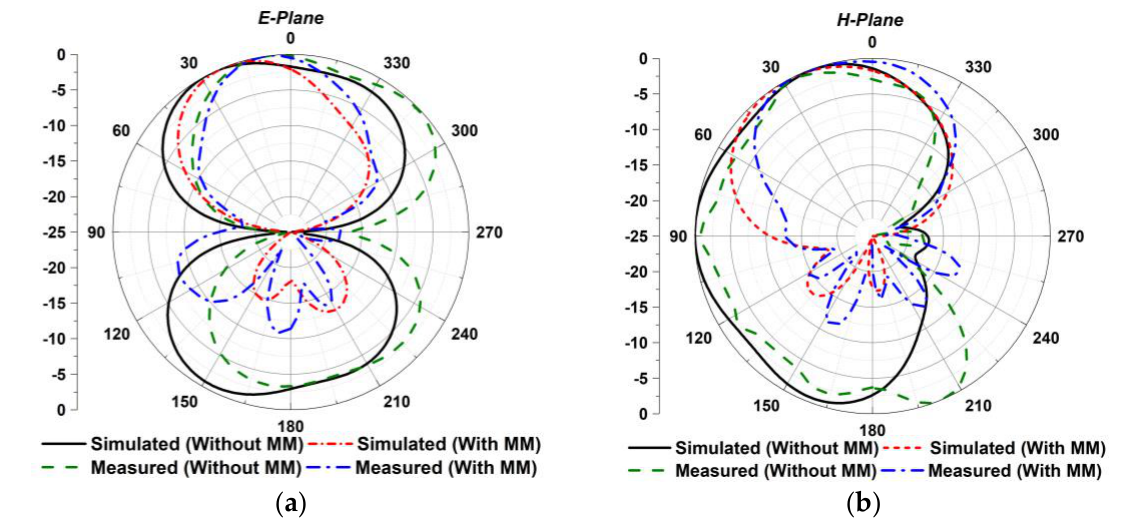
Figure 12. Simulated and measured radiation patterns of the developed MIMO antenna at 4.5 GHz ( a ) E-plane and ( b ) H-plane (without and with MM).